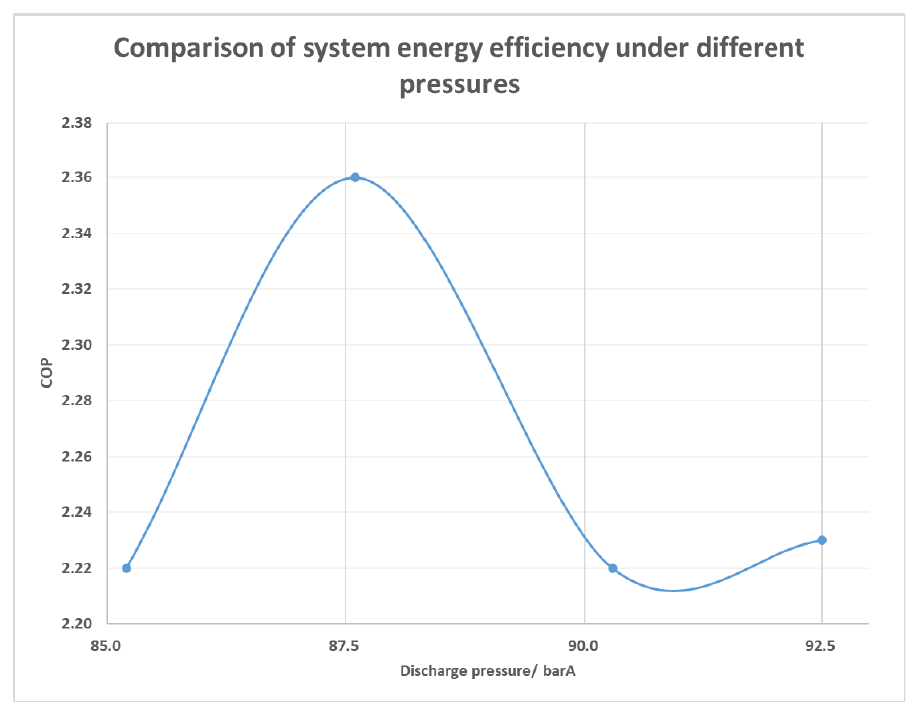
Figure 5. Variation in COP for the R744 system along with discharge pressure at 35 °C.